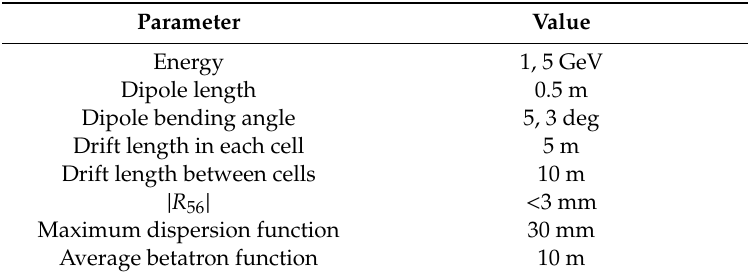
Table 2. Parameters of a switchyard made of two double-bend